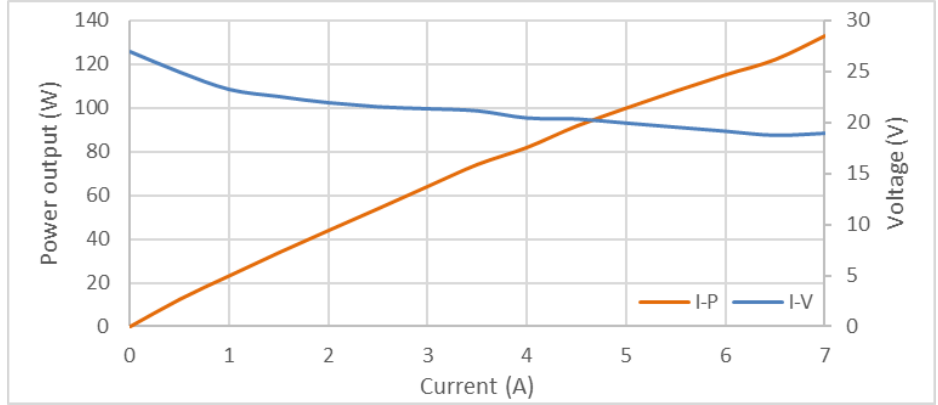
Figure 7. Polarization curves (Voltage and power as a function of current) of the PEMFC, as measured without a WRS.